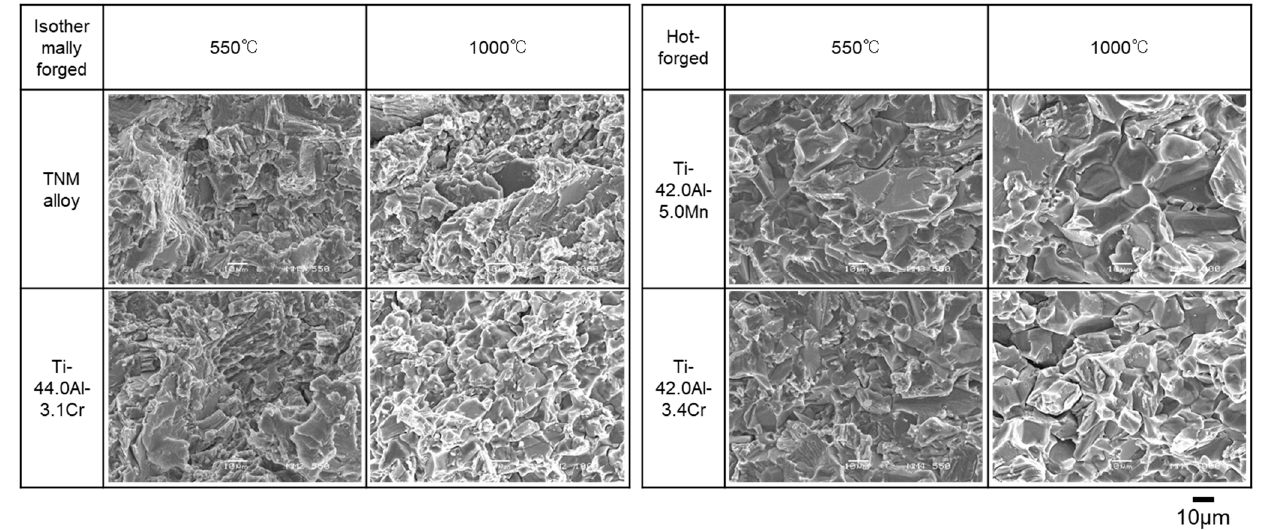
Figure 7. Comparison of average Charpy absorbed energies of forged TiAl alloys at various temper- atures, as well as those of the cast Ti-46.5Al and Ti-46.5Al-1.6Cr.